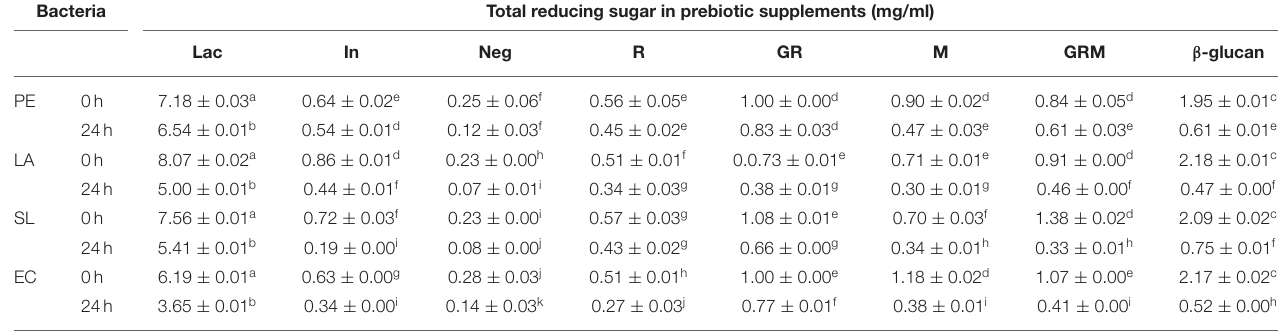
TABLE 2 | Total reducing sugar content in sample used in this study. Bacteria Total reducing sugar in prebiotic supplements